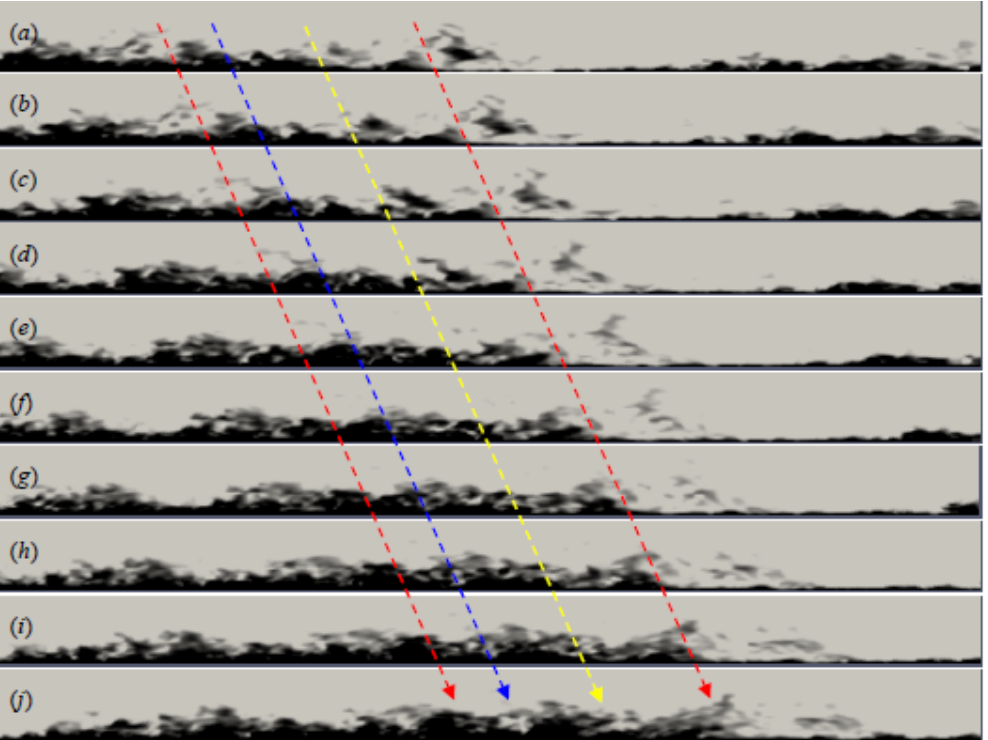
Figure 19. Evidence of the streamwise scale growth and extinction in xz plane. Subfigures ( a – j ) represent the time evolution of flow field.